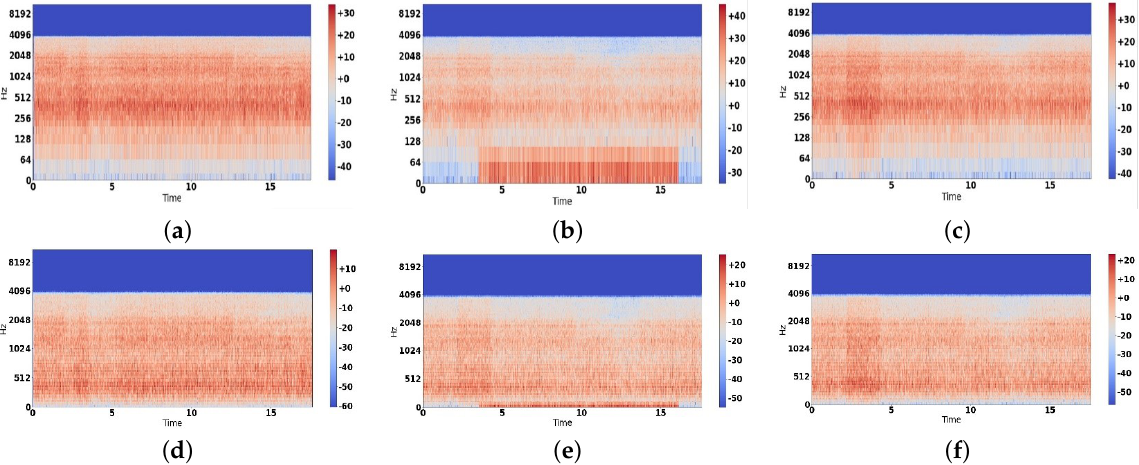
Figure 6. Log spectrogram representation of different classes: ( a ) Normal class, ( b ) Superelevation class, and ( c ) Wheel burnt class; Mel spectrograms after applying Mel filter bank: ( d ) Normal class, ( e ) Superelevation class, and ( f ) Wheel burnt class.